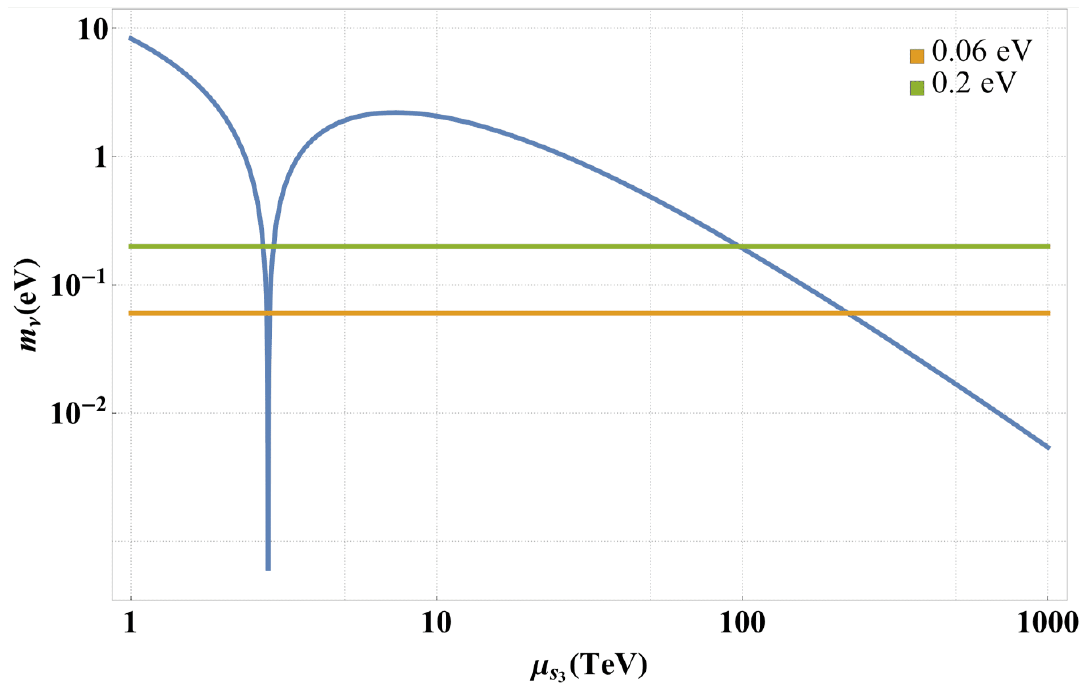
Figure 5 . Plot of the sum of neutrino masses, m (cid:23) , in eV, for leptoquark mass parameter (cid:22) S ranging 3 from 1{100 TeV. The other exotic mass parameters and the quartic and cubic scalar coupling values have been (cid:12)xed: (cid:22) S = 7 : 5 TeV, (cid:22) (cid:30) = 1 : 5 TeV, (cid:21) S = 1 and m S = 1 : 5 TeV. All entries 1 3 3 (cid:30) 3 H 1 S 3 (cid:30) 3 in the leptoquark and diquark coupling matrices have been set to y LL = 0 : 001 and z LL = 0 : 01 3 ij 1 ij respectively. The solid horizontal orange line indicates the experimental lower bound of 0 : 06 eV, while the green line shows the approximate cosmological upper limit of 0 : 2